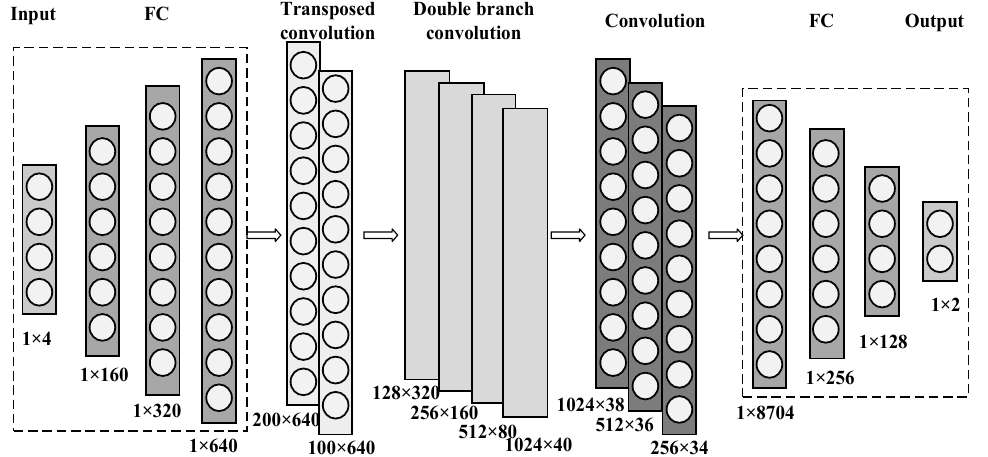
Figure 5. The neural network structure diagram finally determined in this paper includes, from left to right, four input layers, three fully connected modules, two transpose convolutional modules, four double-branch convolutional modules, three convolutional modules, three fully connected modules, and two output layers. At the bottom of each layer, the number of neurons is marked.